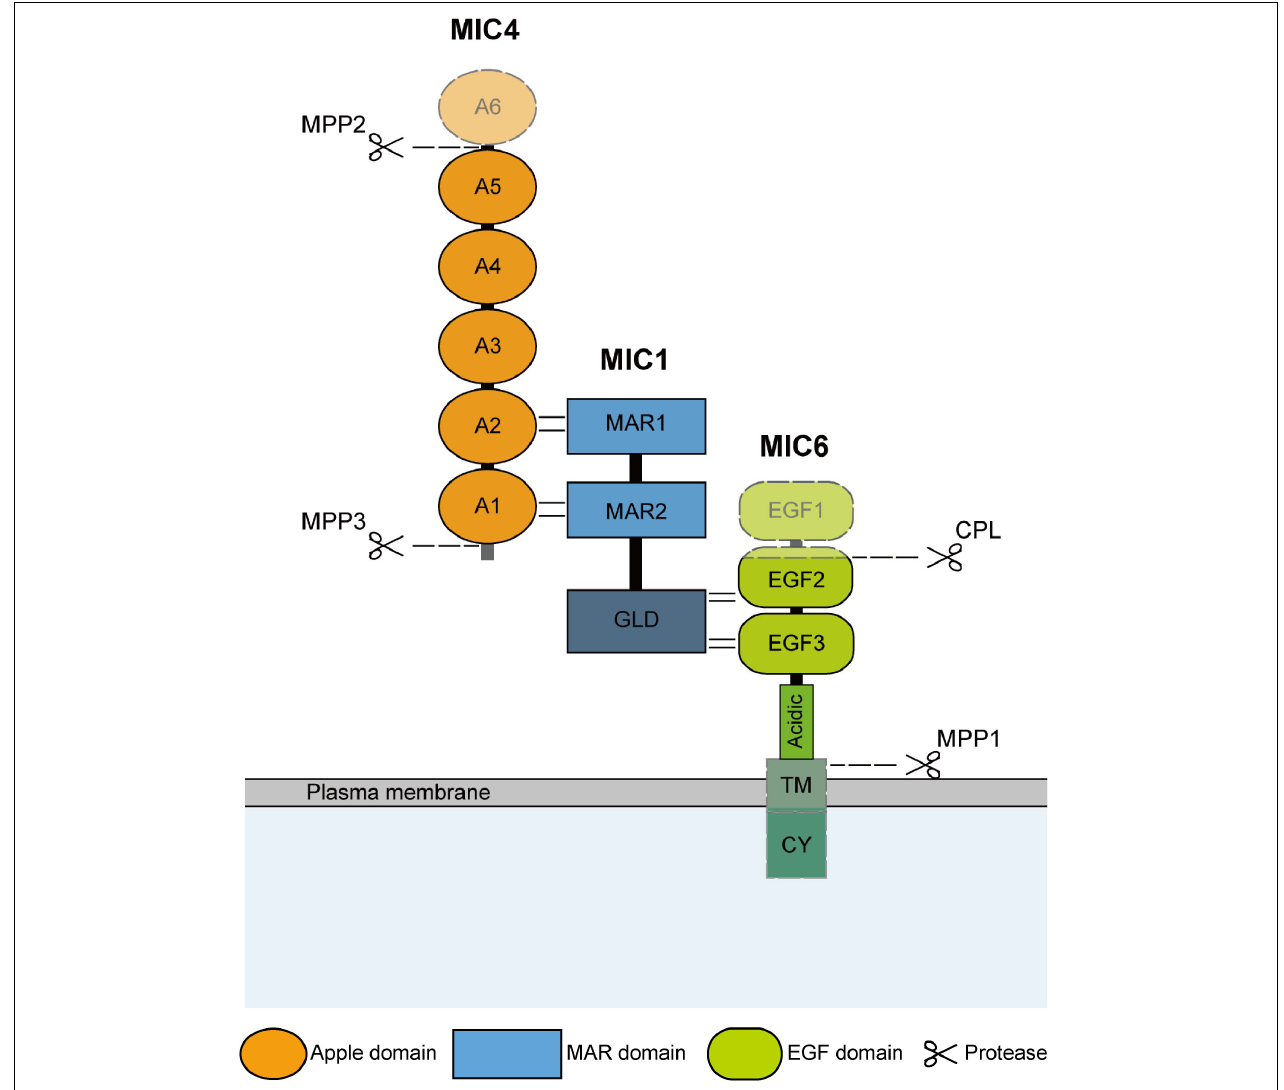
FIGURE 1 | Schematic representation of domain structure and hydrolysis modification of TgMIC1/4/6. The domain structure and interaction sites of TgMIC1/4/6 are shown. And the C-terminal galectin-like domain (GLD) of MIC1, transmembrane (TM) and cytoplasmic domain (CY) of TgMIC6 are also indicated. TgMIC4 and TgMIC6 undergo hydrolysis modification by MPP2, MPP3, and CPL, respectively, during transport to the microneme, and then the complex is anchored on the surface of the parasites by TgMIC6, and finally released by MPP1 after the invasion is completed. The cleavage sites are all plotted.